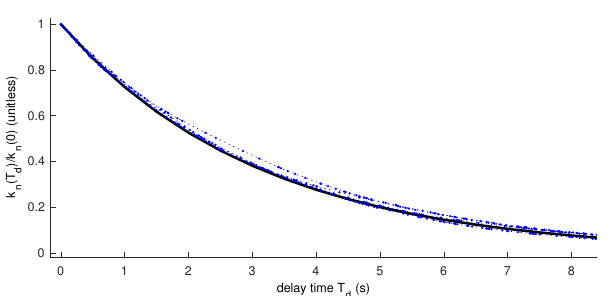
Figure 1. Low- λ approximation. Dashed blue lines with dots: Four experimental runs. Thick black √ ∆ T ) T / ∆ T P P line: ( 1 − σ Q , σ R